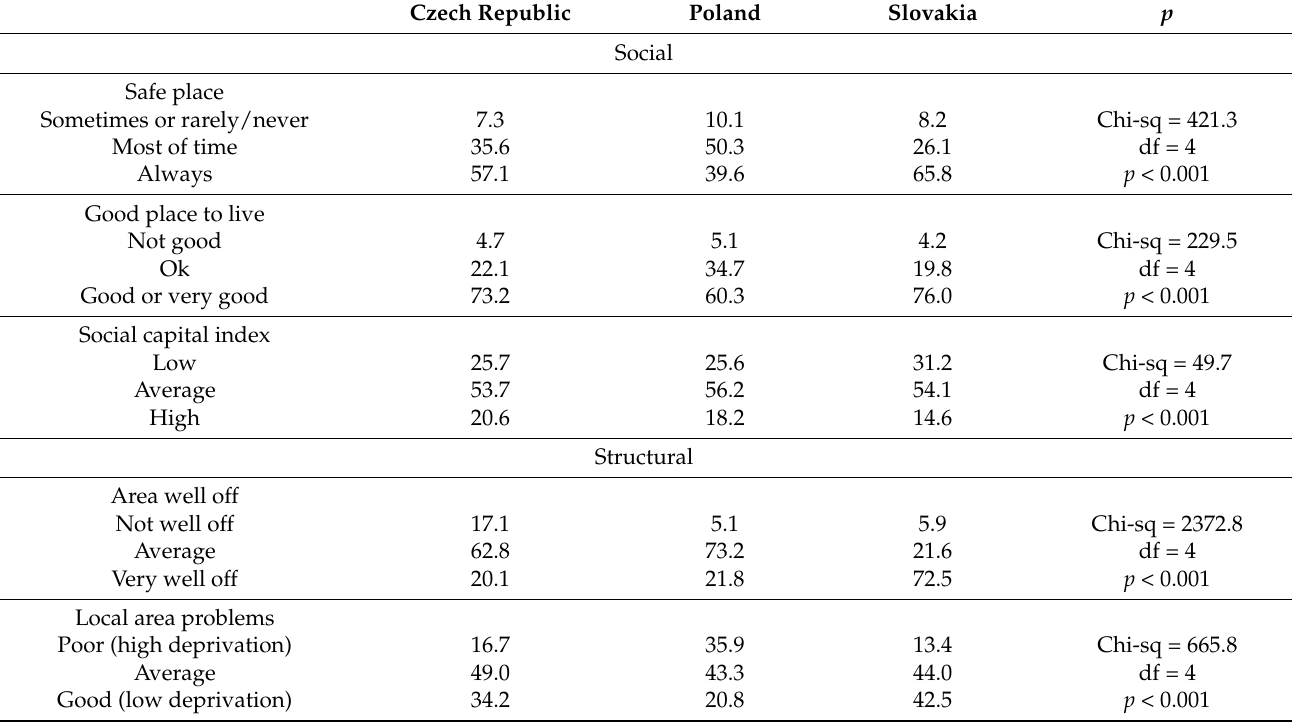
Table 2. Samples by neighbourhood features